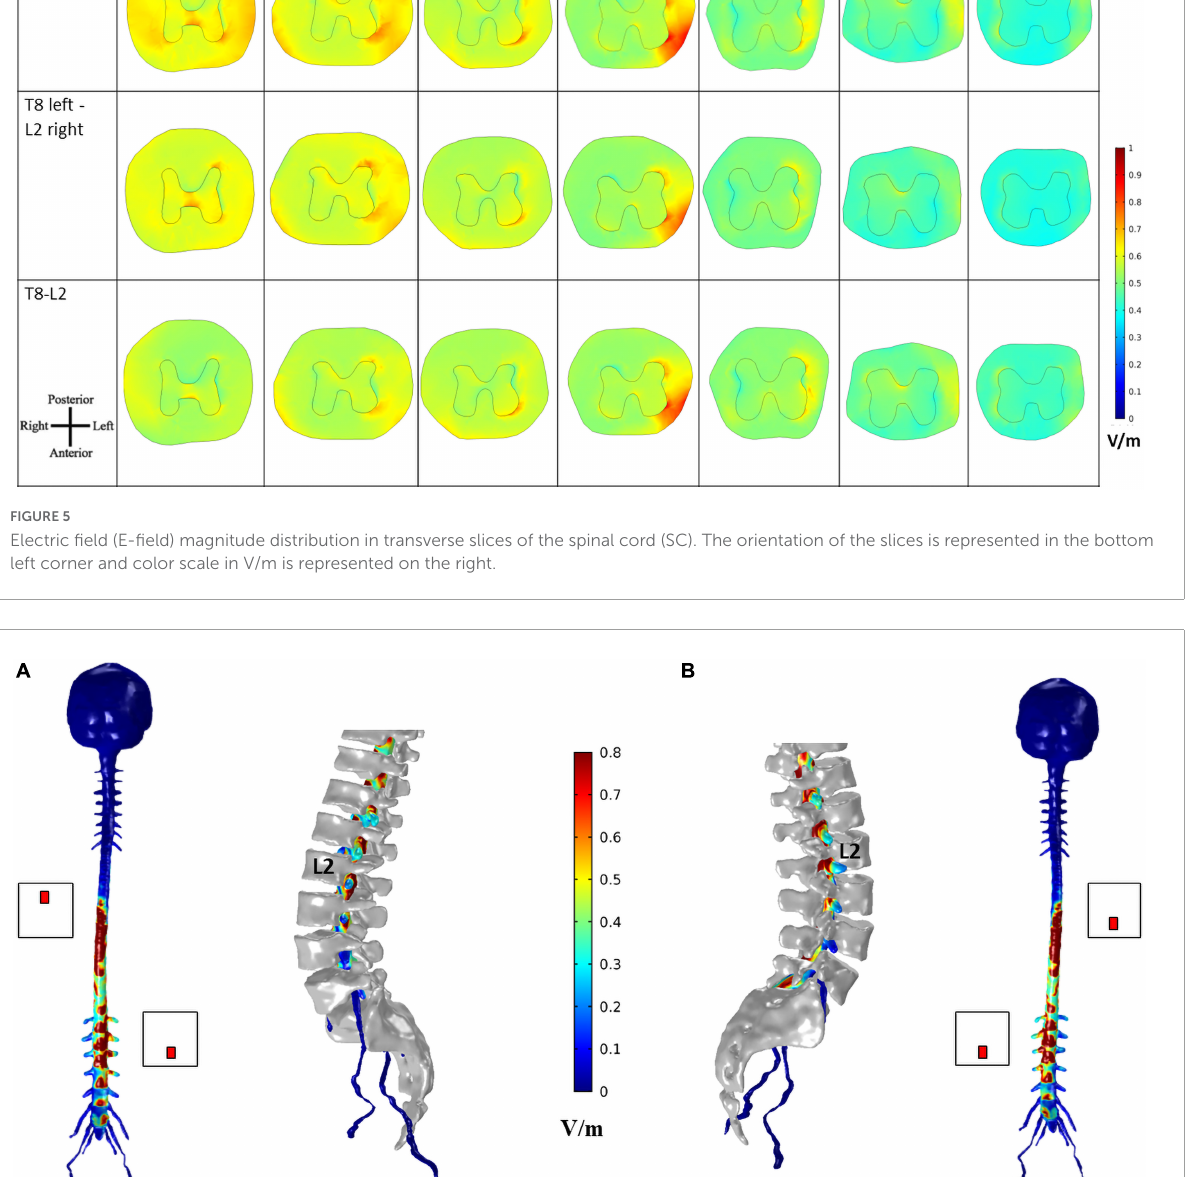
stimuli (3 Hz) with an intensity able to induce a slight muscle contraction were delivered. Recordings were performed according to the guidelines and two sets of recordings